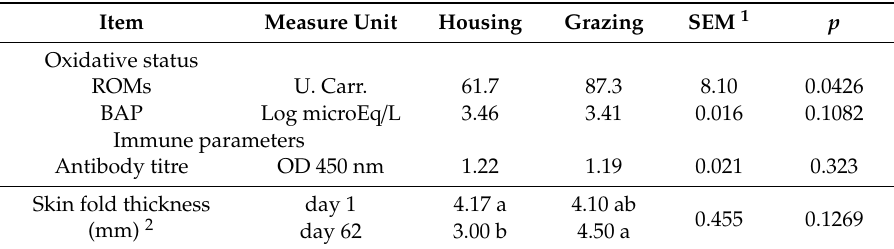
Table 3. E ff ect of feeding system on oxidative and immune